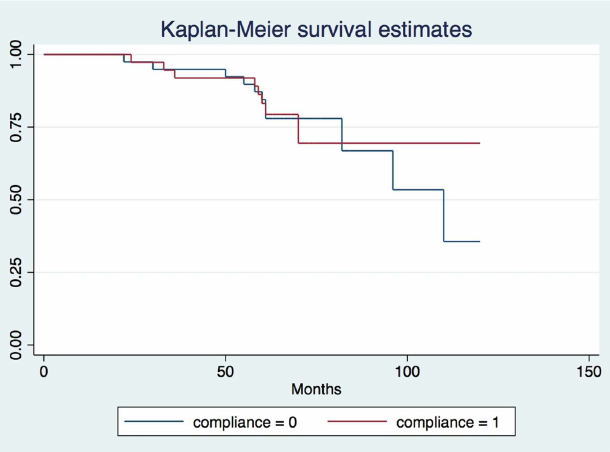
Figure 2. Kaplan–Meier survival curves for ICs (compliance code = 0) and RCs (compliance code =